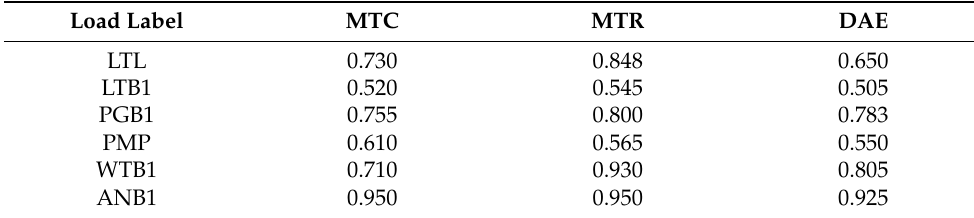
Table 12. Power estimation accuracy performance by MTC, MTR, and DAE